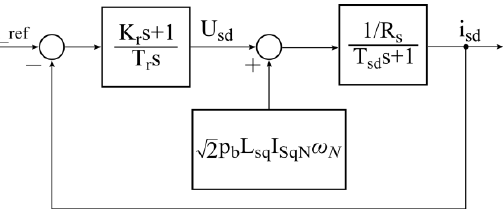
Figure 8. Schematic diagram of the current control system in the 𝑑 axis of the PMSM.